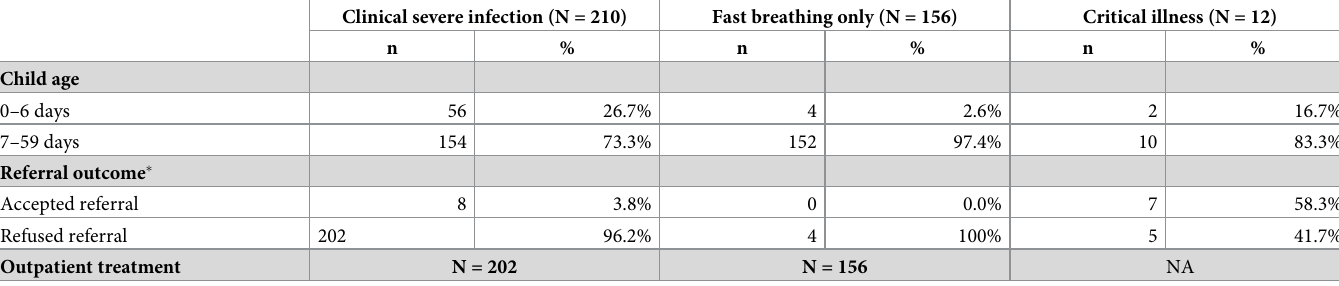
Table 2. Results of assessment and screening procedures by PSBI case type (N = 378).